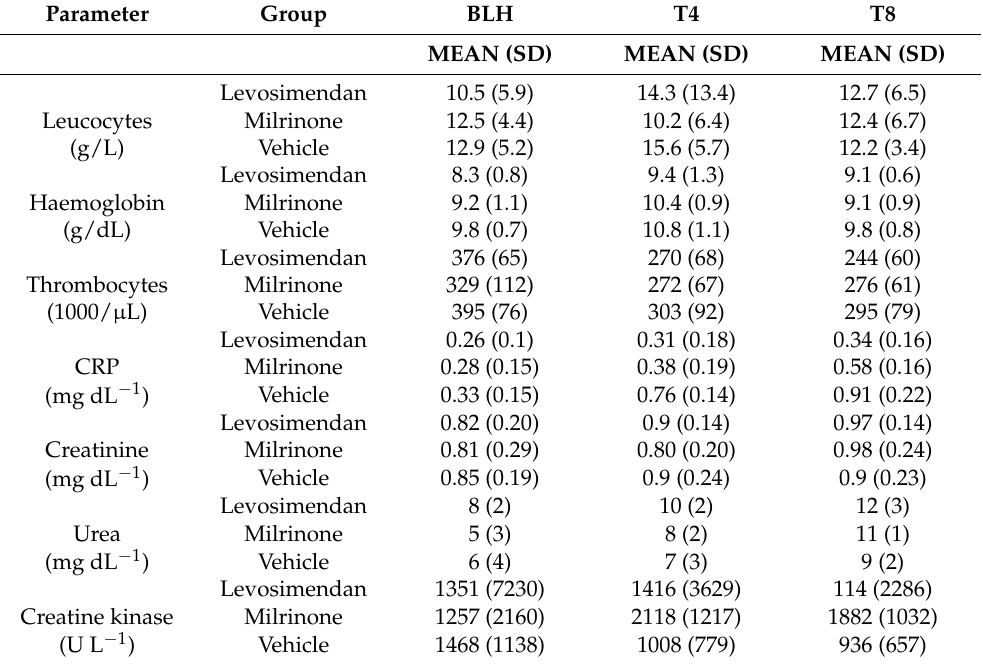
Table 3. Laboratory diagnostics. Values are mean (SD). BLH: baseline healthy; CRP: C-reactive protein. Parameter